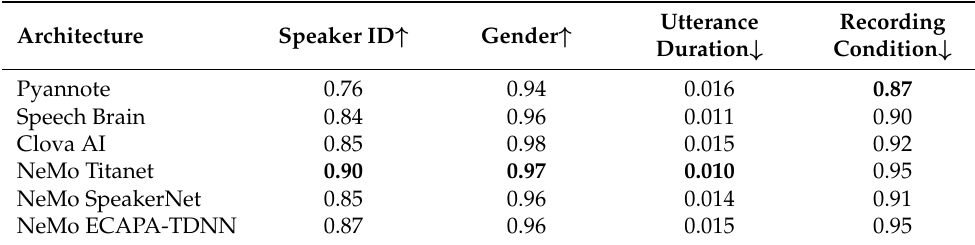
Table 4. F1-scores for various classification tasks. Arrows mark the direction of best performance. Best results are highlighted in boldface.